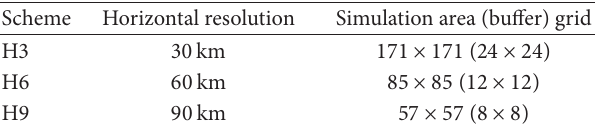
Table 1: Designed experimental schemes based on horizontal